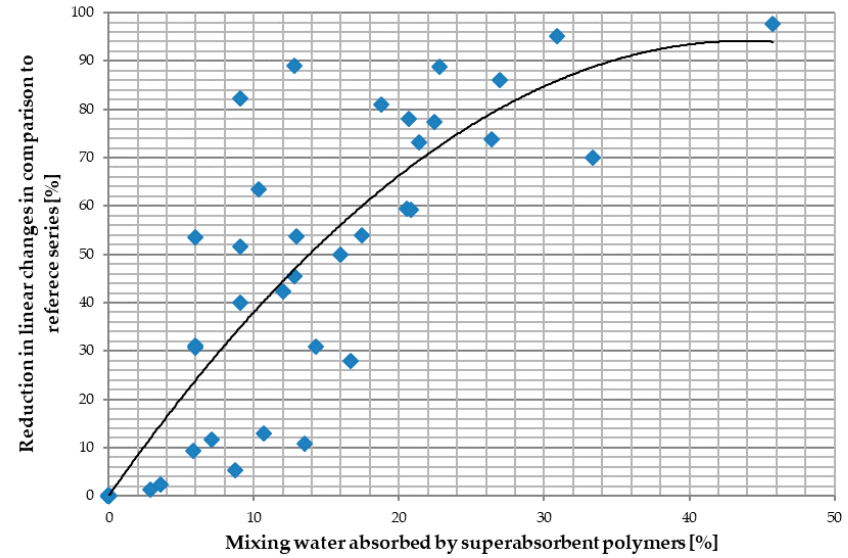
Figure 1. Reduction of linear changes in relation to the reference series not modified